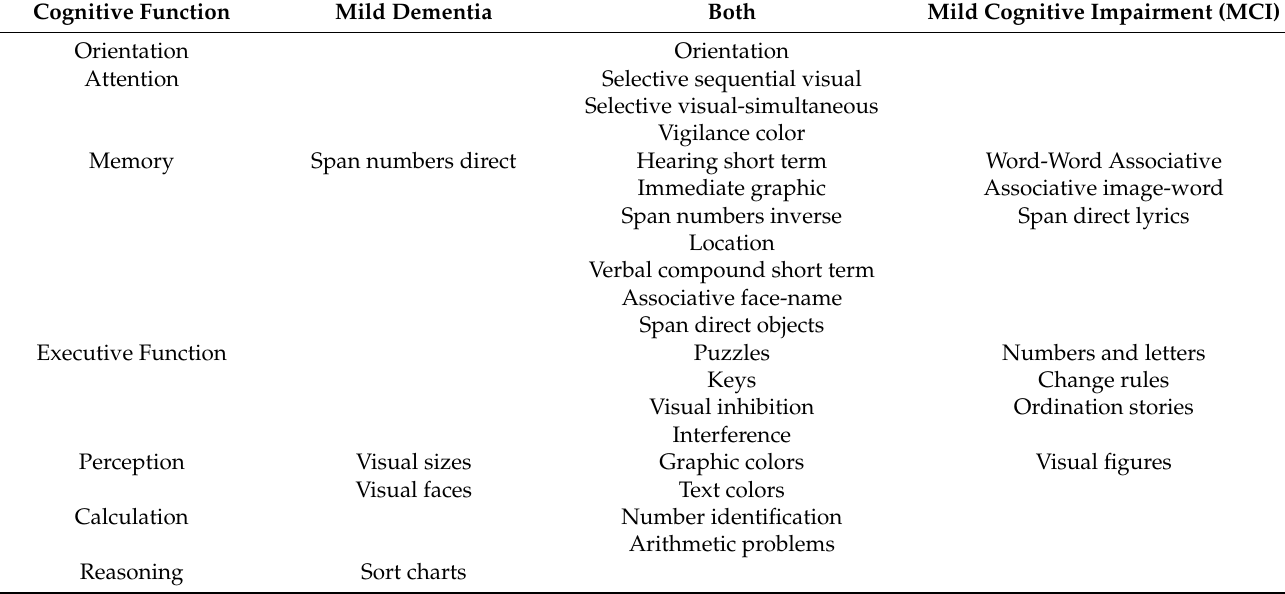
Table 1. “GRADIOR” computer-based cognitive training (CCT) plan according to modalities and sub-modalities for participants with mild cognitive impairment (MCI) and mild